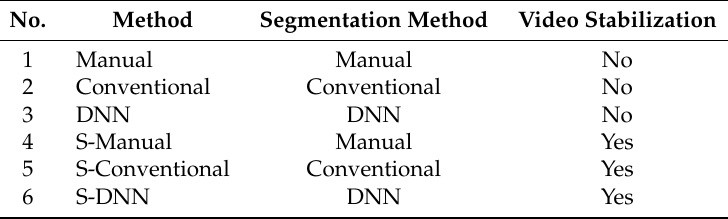
Table 1. Method configuration.